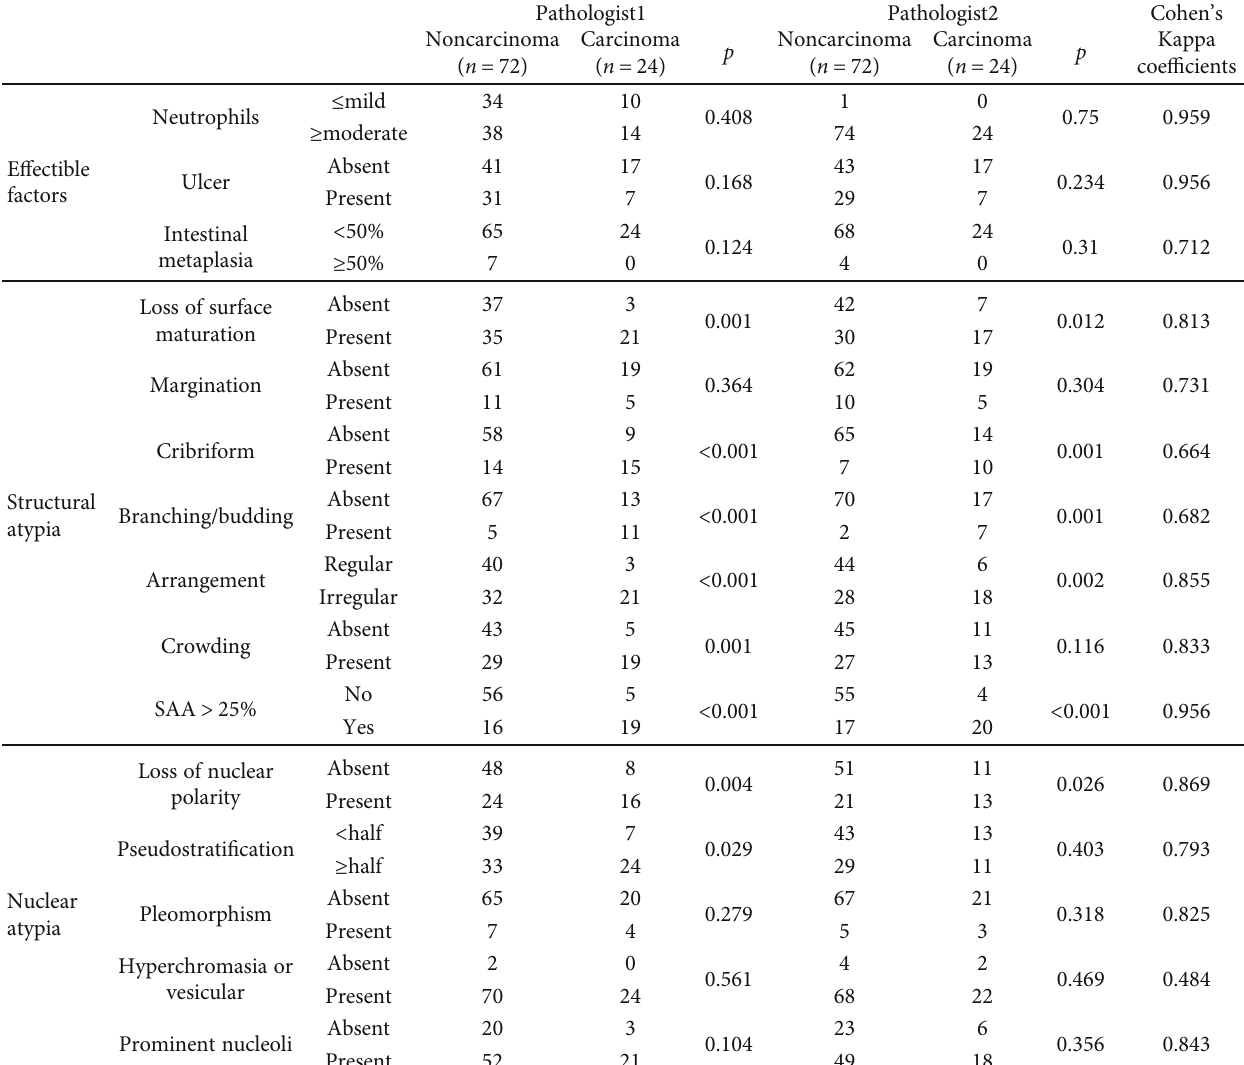
Table 4: Interpretation of results of pathologic factors for predicting carcinoma by two